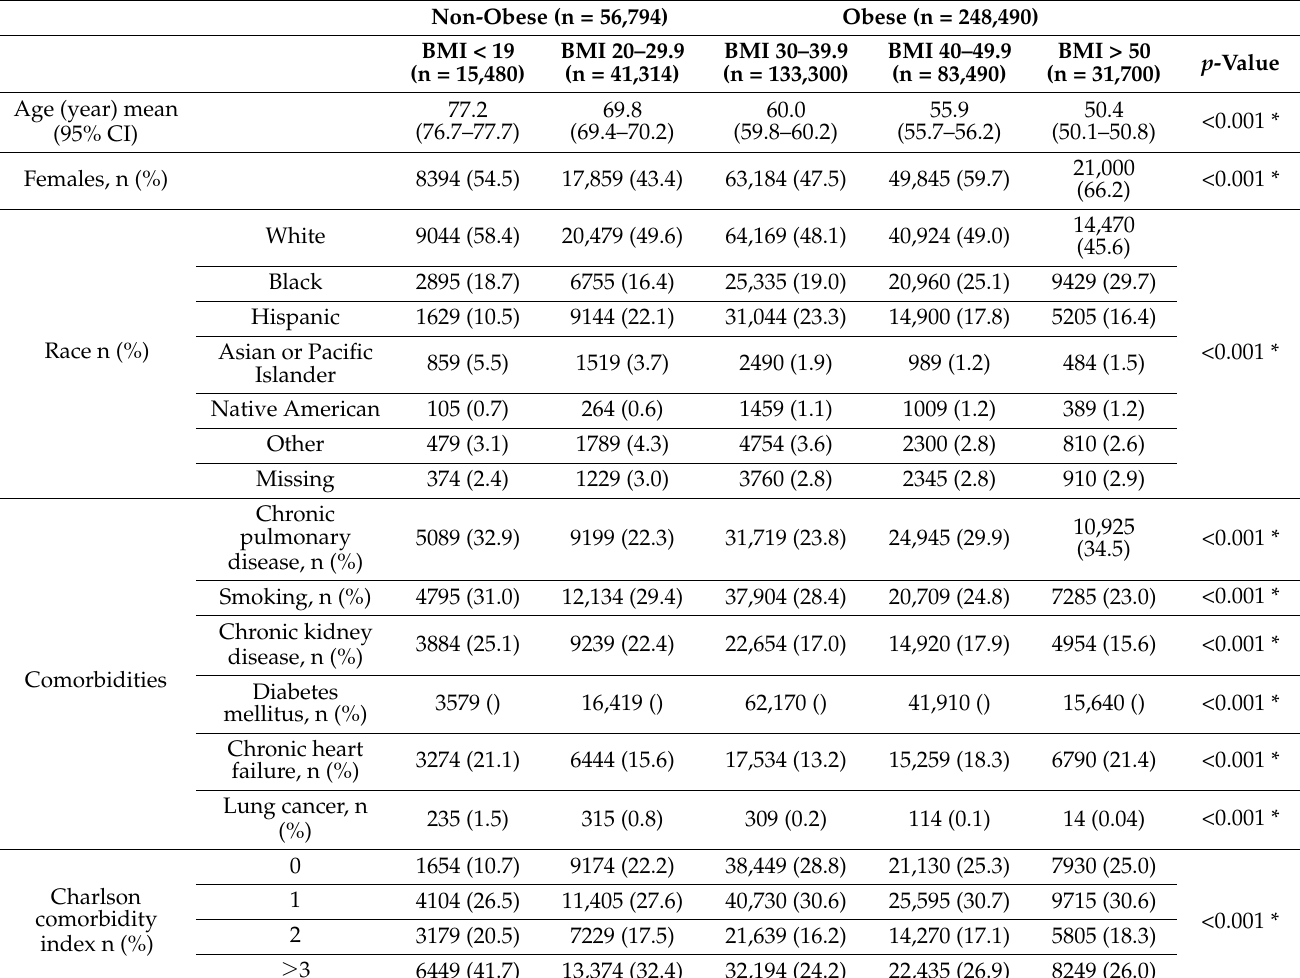
Table 1. Patient baseline characteristics.